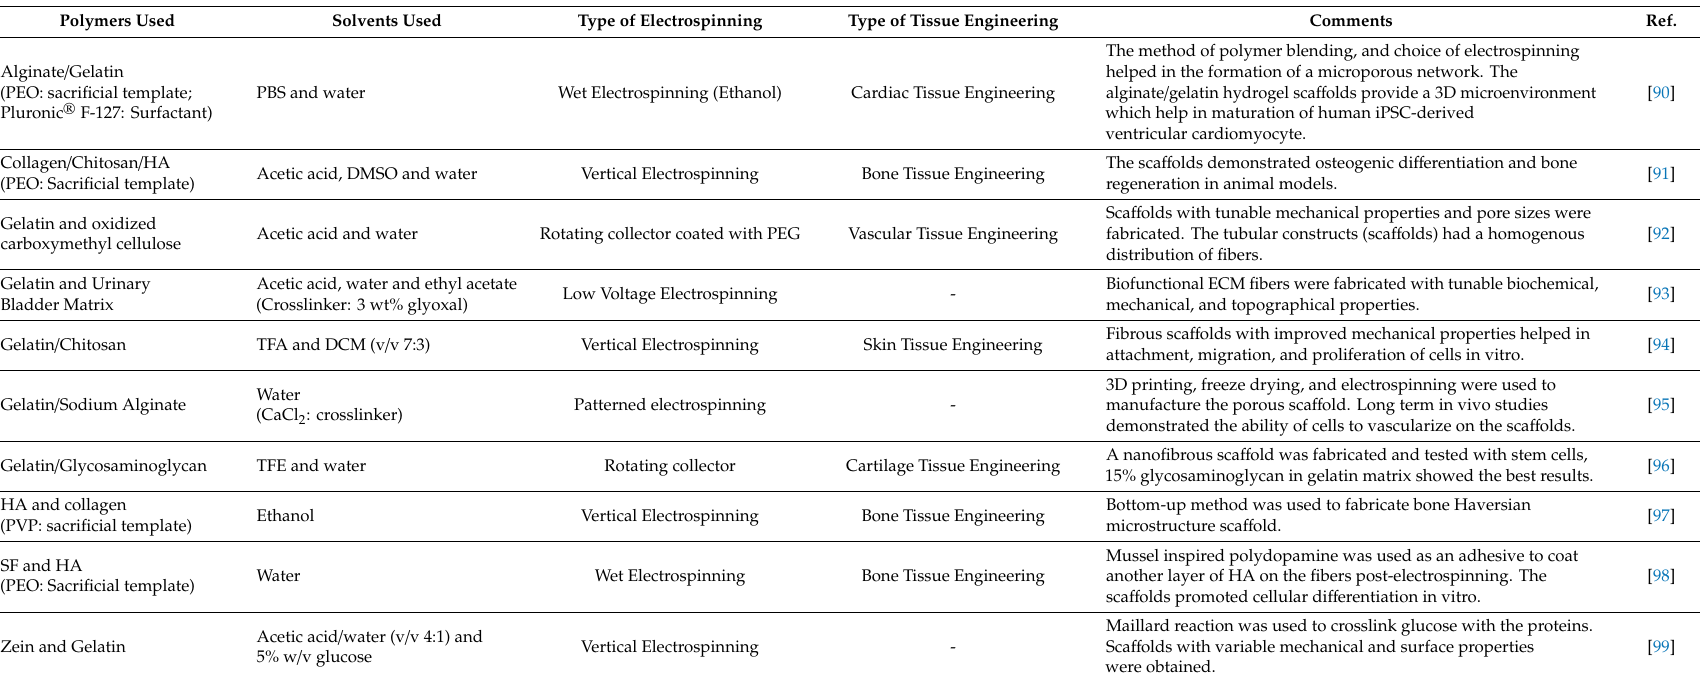
Table 2. Electrospun sca ff olds based on natural polymer